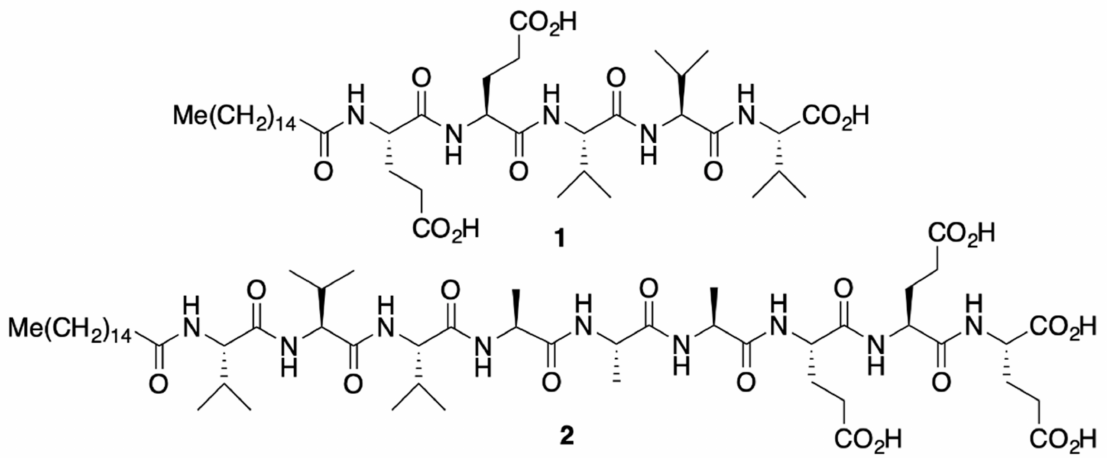
Figure 5. Chemical structures of compounds 1 and 2